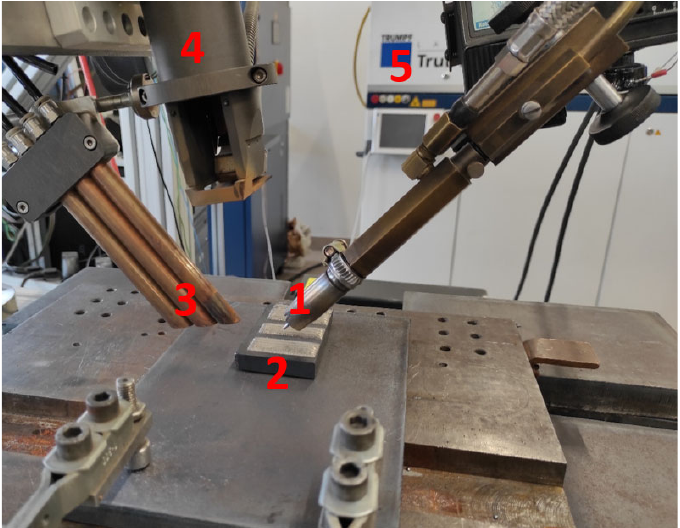
Figure 1. The experimental setup for laser cladding of composite powder: 1 — nozzle for powder delivery, 2 — coated sample, 3 — shielding nozzles, 4 — laser head, 5 — laser